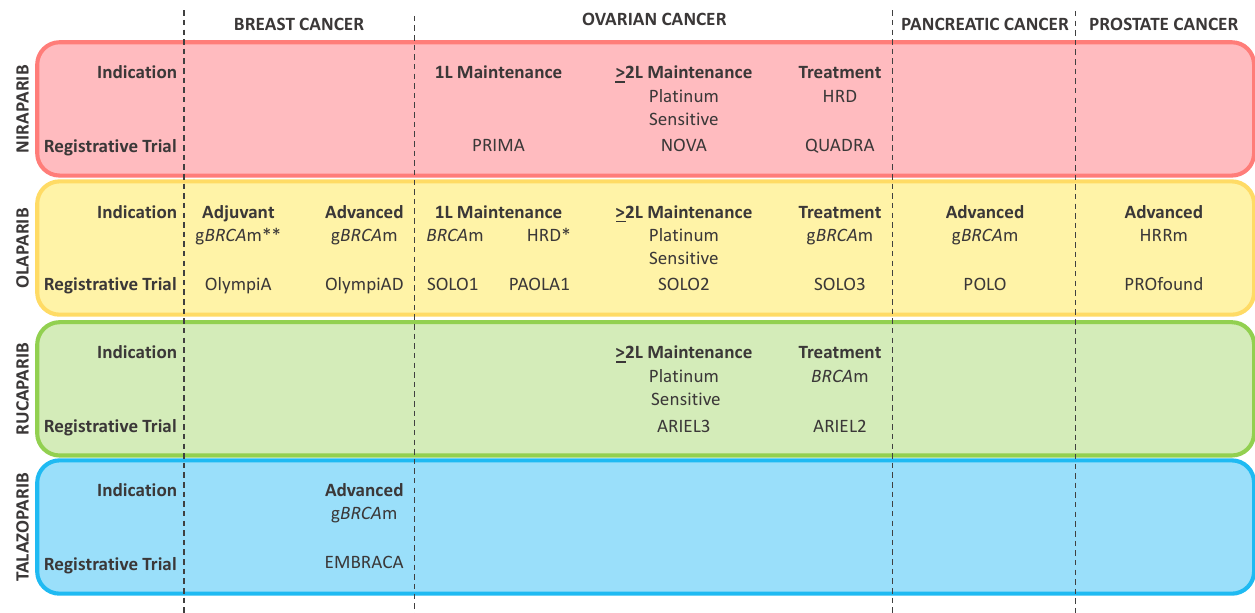
Figure 1. Currently approved indications of PARP inhibitors according to the Food and Drug Administration. * Olaparib in combination with bevacizumab; ** This indication has not been approved yet, but has been granted an accelerated review process by the Food and Drug Administration on 30 November 2021. Figure Legend: 1L first line therapy; 2L second line therapy; BRCAm: BRCA mutated (germline or somatic); gBRCAm: germline BRCA mutated; HRD homologous recombination deficiency; HRRm: homologous recombination repair mutated.